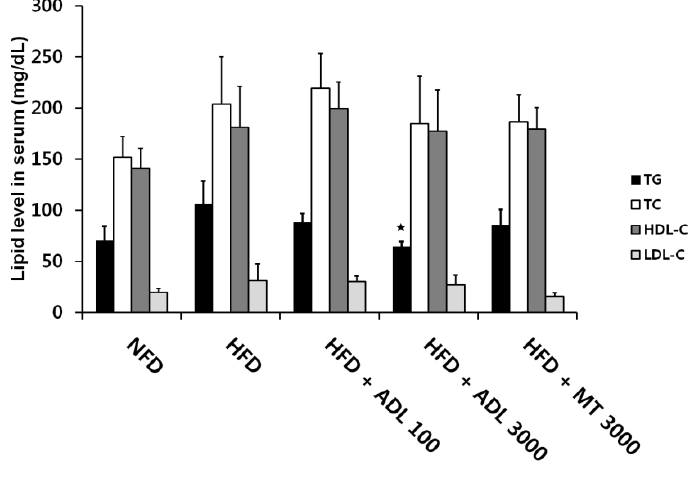
Figure 3. Effects of Allomirina dichotoma larva (ADL) suspension on serum triglyceride (TG), total cholesterol (TC), high density lipoprotein cholesterol (HDL-C), and low density lipoprotein cholesterol (LDL-C). Mice were fed normal-fat diet (NFD), high-fat diet (HFD), HFD supplemented with 100 mg·kg −1 ·day −1 ADL (HFD + ADL 100), HFD supplemented with 3000 mg·kg −1 ·day −1 ADL (HFD + ADL 3000), and HFD supplemented with 3000 mg·kg −1 ·day −1 yerba mate (HFD + MT 3000) for 6 weeks. Serum samples